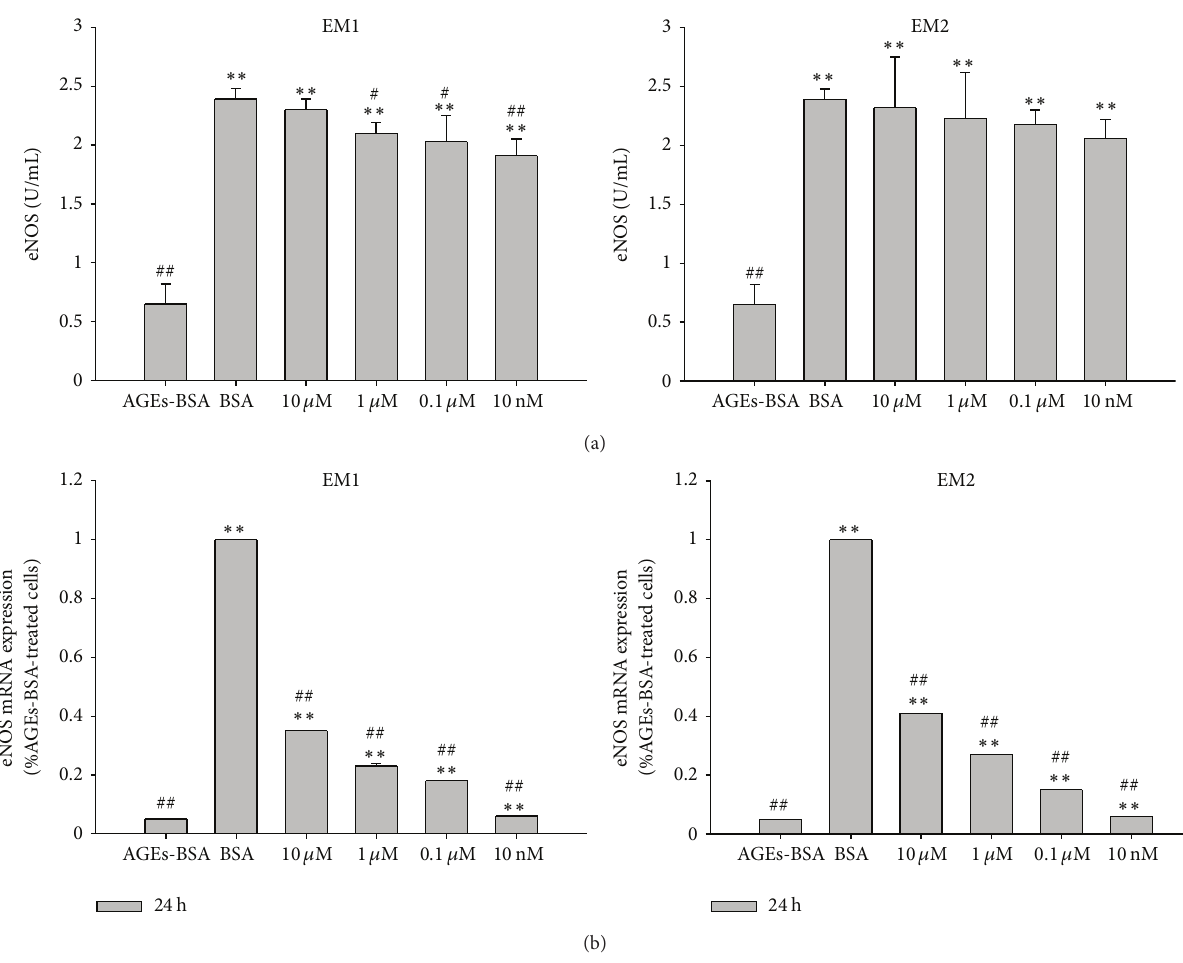
Figure 5: Effect of EM1, EM2 on eNOS secretion determined by ELISA test in HUVEC (a). HUVECs were incubated according to the aforementioned grouping. Each value represents the mean ± SD ( 𝑛 = 3 ); mRNA expression level of eNOS after treatment with AGEs-BSA and EM1 or EM2, using BSA treated cells as reference control (b). The parameter Ct was derived for each cDNA sample and primer pair; for a given sample, Ct values for 𝛽 -actin were subtracted from the Ct of each candidate gene reaction to arrive at a Δ Ct value. The mean Δ Ct from all control reactions was then subtracted from the Δ Ct of each treated sample to arrive at ΔΔ Ct. The relative fold change was calculated by the expression 2 −ΔΔ Ct . Each data is expressed as mean ± SD ( 𝑛 = 3 ). ∗ 𝑃 < 0.05, ∗∗ 𝑃 < 0.005 versus AGEs-BSA group, # 𝑃 < 0.05, ## 𝑃 < 0.005 versus control (BSA)